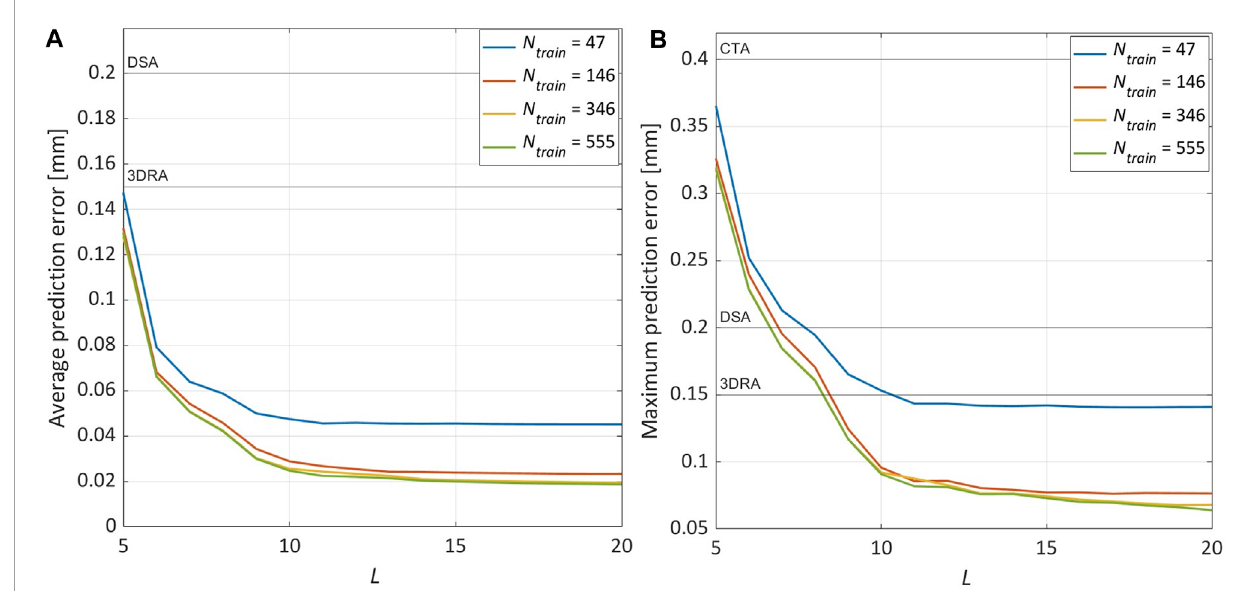
FIGURE 9 Sensitivity analysis on the training database size ( N train ) . The results are obtained with L = 15 and using the centerline points parameters ( μ cl with N cl = 8) as GPR predictors. (A) Evolution of AE p . (B) Evolution of ME p .